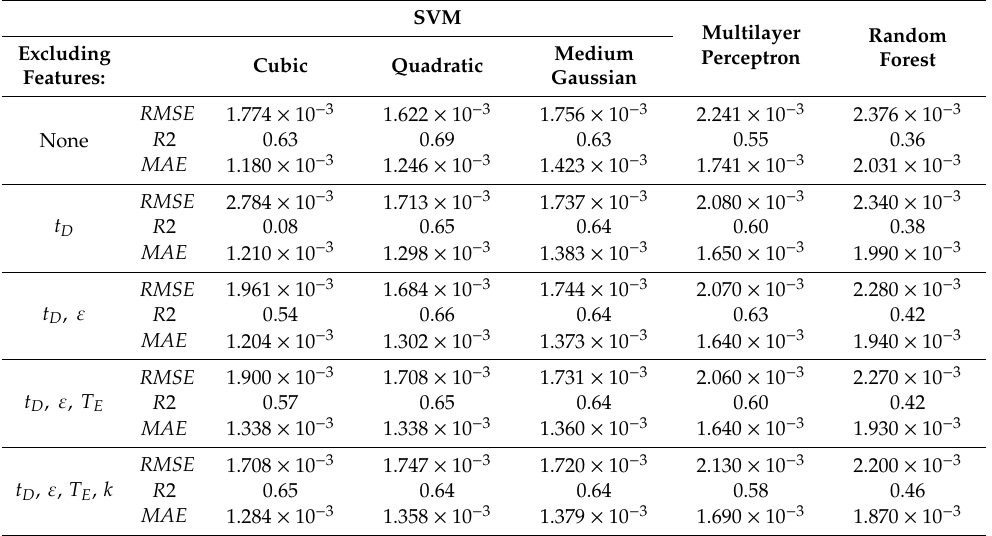
Table 6. Performance results for defect length predictor models using a dataset of 500 sets of values. Part 2: support vector machines (SVM), multilayer perceptron (MLP), and random forest (RF) when “Contrast Rear” is contemplated as feature.